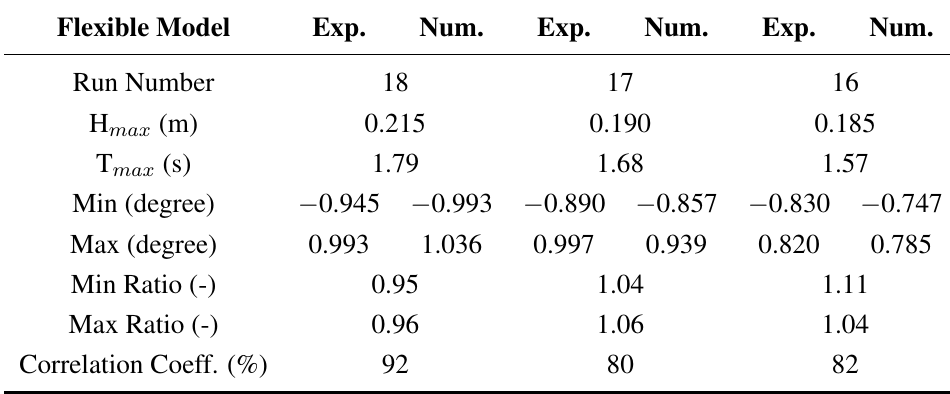
Table 3. Comparison of key data for the pitch motion of the flexible model. Experimental (Exp.) and numerical (Num.) data.